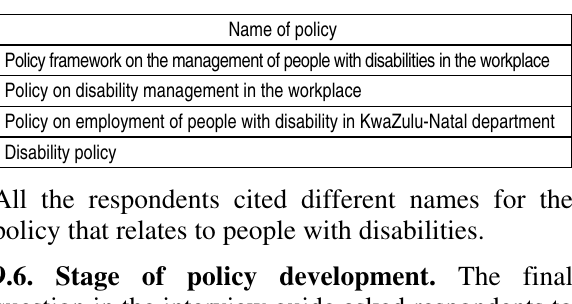
Table 1. Specific policies for people with disabilities